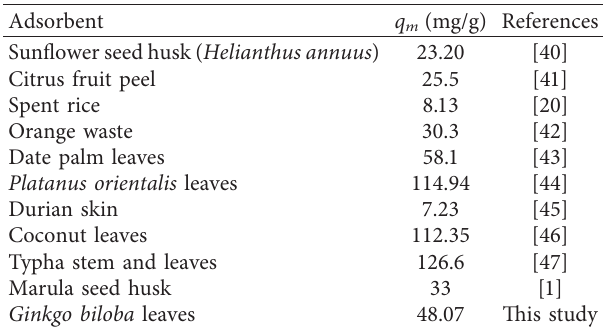
Table 2: Comparisons of the maximum monolayer adsorption of MB onto various unmodified plant-based adsorbents.